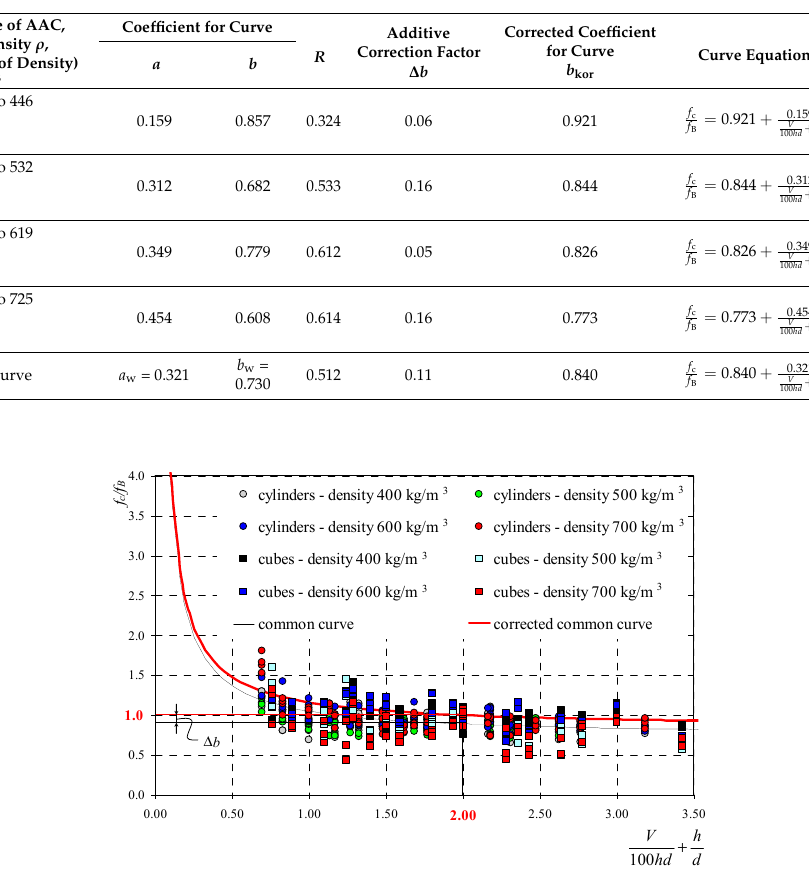
Figure 4. Test results for all core and cube specimens and determined curve of Figure 4 . Test results for all core and cube specimens and determined curve of correlation. When specimens 100 mm × 100 mm × 100 mm were used, the value of curve dominator was V /100 hd + h/d = 2, and strength ratios calculated according to equations from Table 4 were f c / f B ≠ 1.